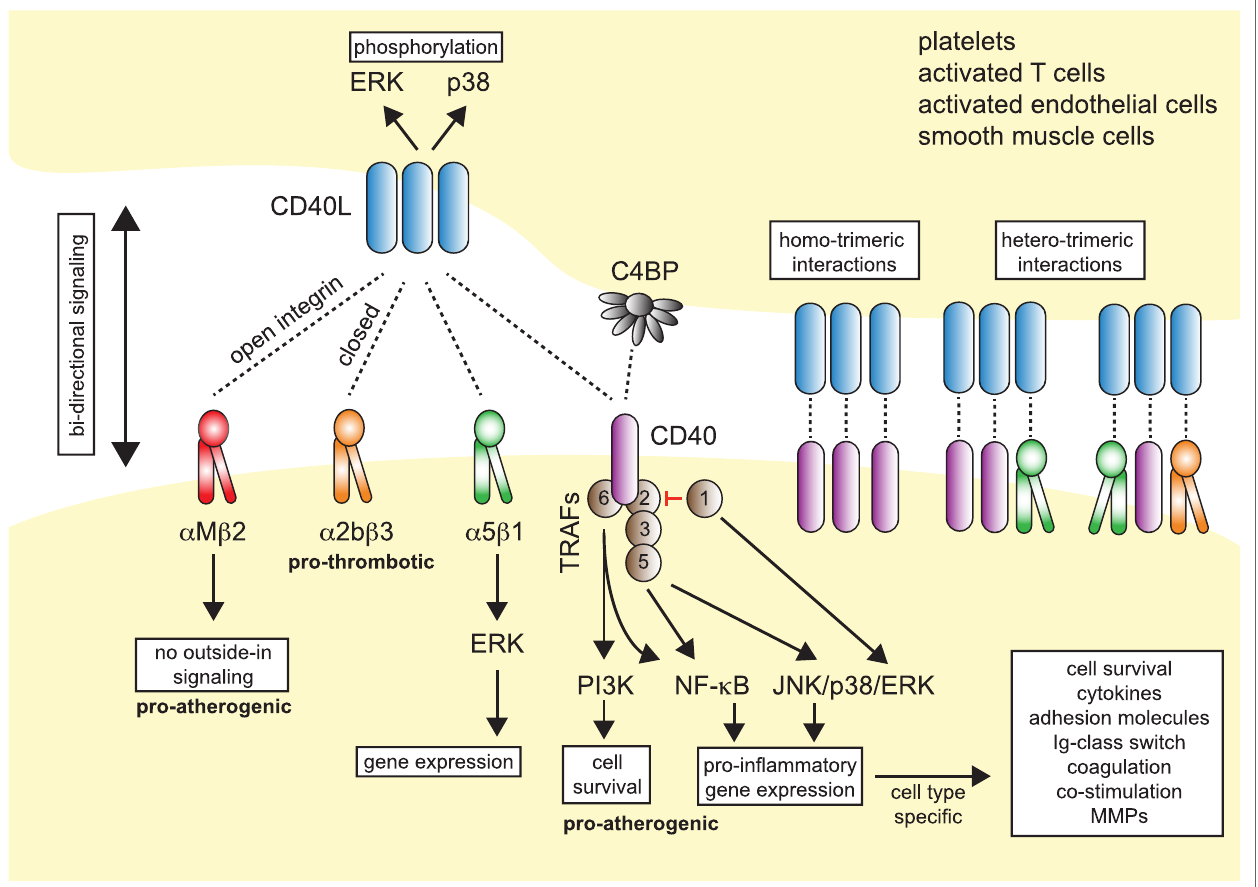
FigURe 1 | Model of CD40L–receptor interactions. Membrane-bound CD40L forms biologically active trimers that can interact with one of its known receptors, the integrins α IIb β 3, α 5 β 1, α M β 2 (Mac-1), or its “classical” receptor CD40. While binding to CD40 occurs statically, binding to integrins can be enhanced by activation-induced conformational changes of both subunits that expose the ligand-binding site (inside-out signaling). Binding to Mac-1 occurs predominantly through the activated integrin, binding to α 5 β 1 requires no previous cell activation and switching into the open, high-affinity conformation. Binding to α IIb β 3 usually occurs through the open conformation, but exact binding properties to CD40L have not been investigated in detail. Besides CD40L, CD40 can also interact with the complement-factor C4b-binding protein (C4BP). Binding of CD40L to one of its receptors induces downstream signaling events, except for Mac-1, for which CD40L serves as biased agonist without induction of outside-in signaling. Binding to α 5 β 1 causes an activation of MAP-kinase signaling pathways, ligation to CD40 causes activation of mitogen-activated protein kinase (MAPK)-, phosphoinositide 3-kinase (PI3K)-, and nuclear factor- κ B (NF- κ B)-signaling events and subsequent pro-inflammatory gene expression. The consequences of CD40 signaling depend on the target cell type. On the contrary, ligation of CD40L to a receptor induces bidirectional signaling events in CD40L-bearing cells, e.g., T cells, B cells, or platelets, possibly by induction of MAPK signaling cascades. Binding of CD40L to its ligands can occur in a homotrimeric fashion, where a trimer of CD40L binds three monomers of CD40, or in a heterotrimeric fashion, where each monomer (of a trimer of CD40L) can bind to different receptors, which was demonstrated for CD40, α IIb β 3, and α 5 β